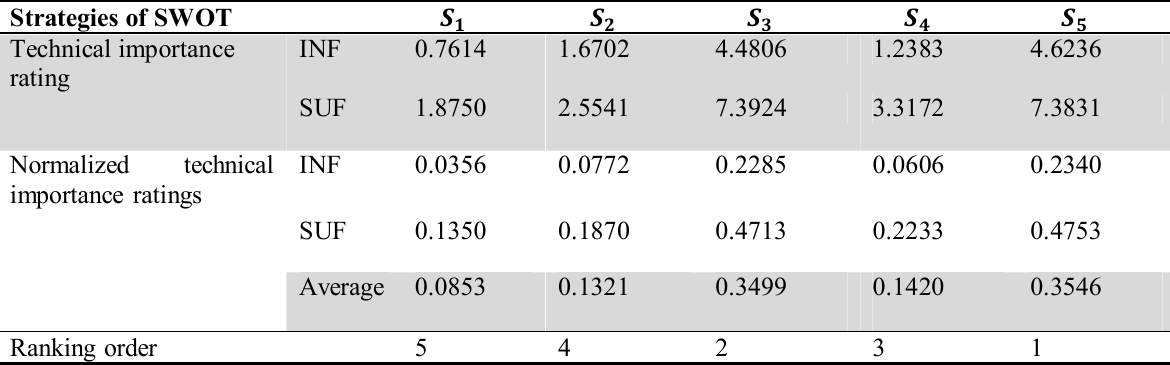
Normalized technical importance ratings Strategies of SWOT Technical importance